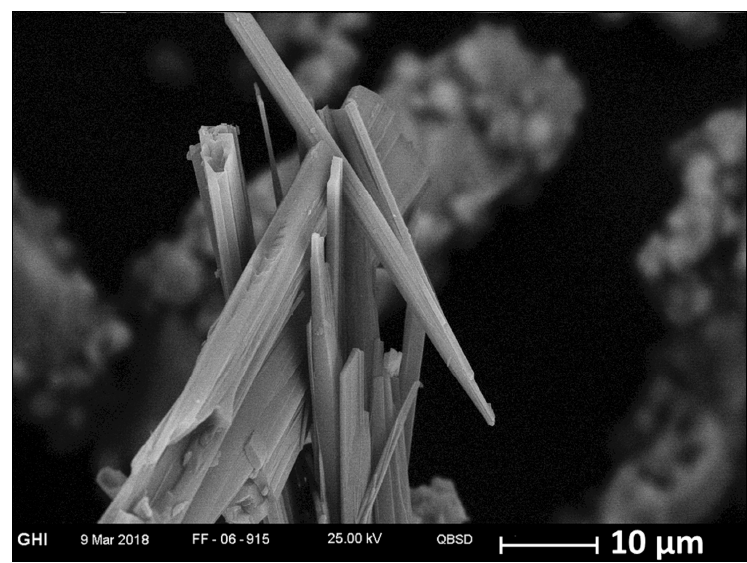
Figure 5. Acicular tremolite as found within the microstructure investigation of an olivine sample after carbonation.